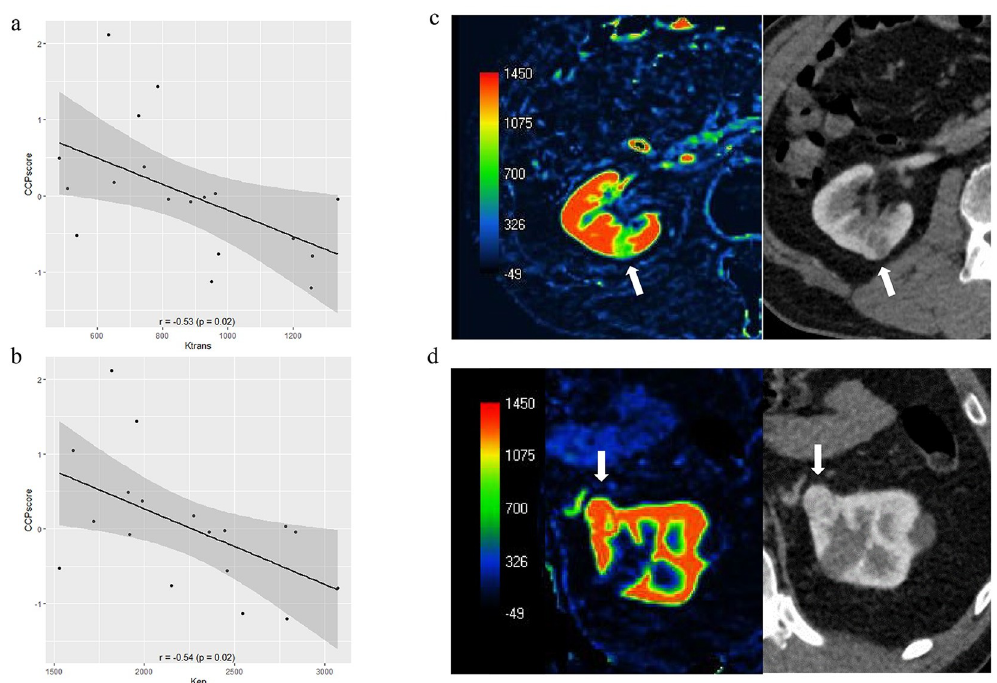
Fig 4. The relationships between the CCP score and the perfusion parameters. a: Ktrans was inversely correlated with the CCP score (r = − 0.53, p = 0.02). b: Kep was inversely correlated with the CCP score (r = − 0.54, p = 0.02). c,d: Two cases of clear cell carcinoma (arrow). They are the same size (18 mm), but the Ktrans value and the CCP score vary between them. c: The Ktrans is 509 and the CCP score is 0.09. d: The Ktrans is 1200 and the CCP score is − 0.56.